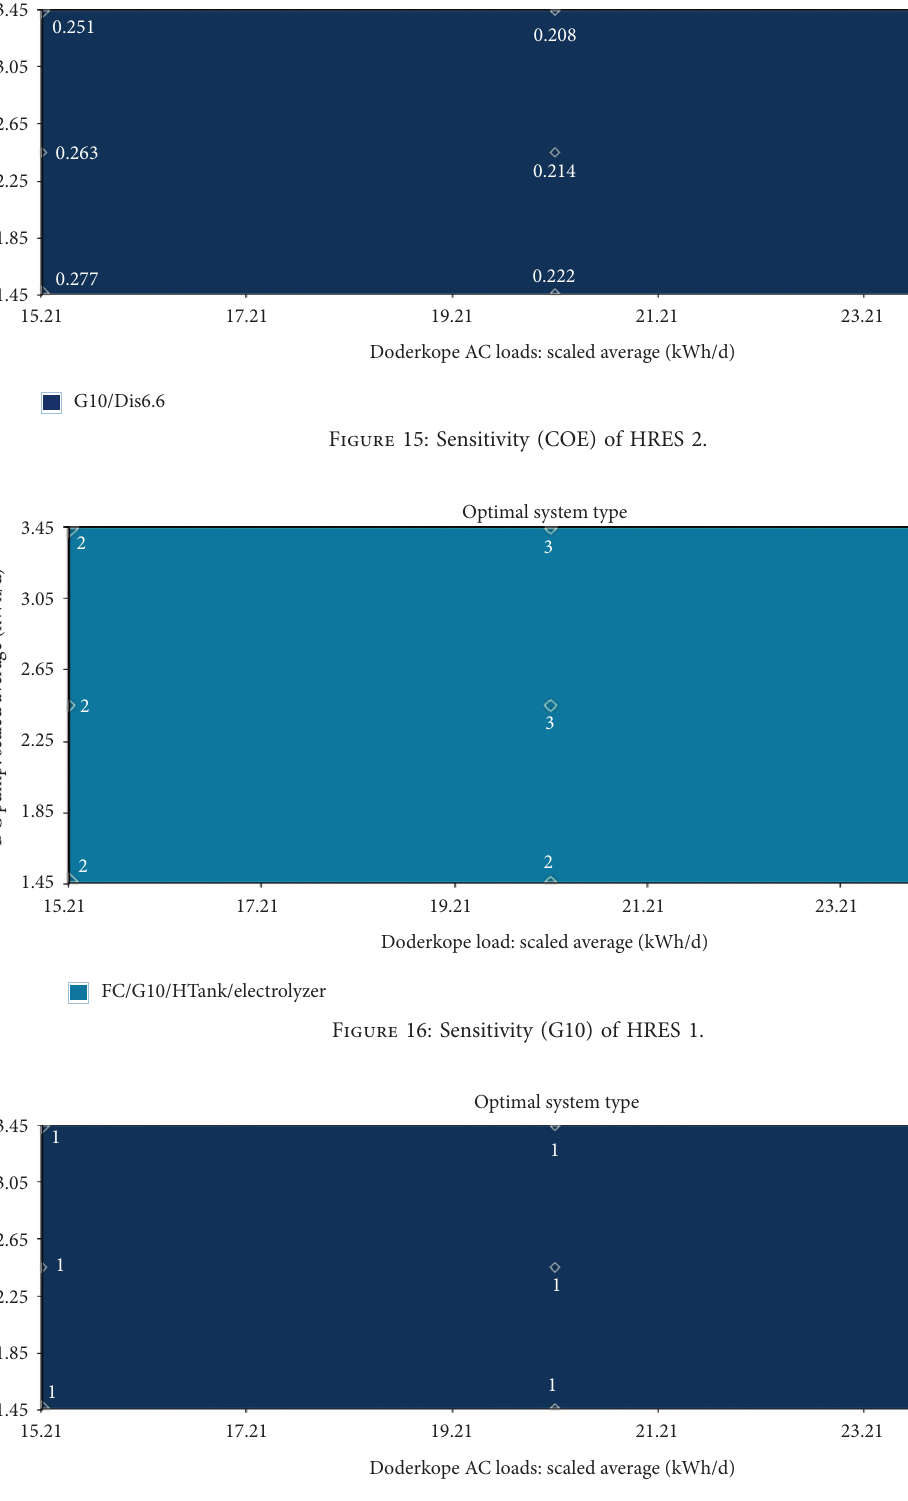
Figure 17: Sensitivity (G10) of HRES